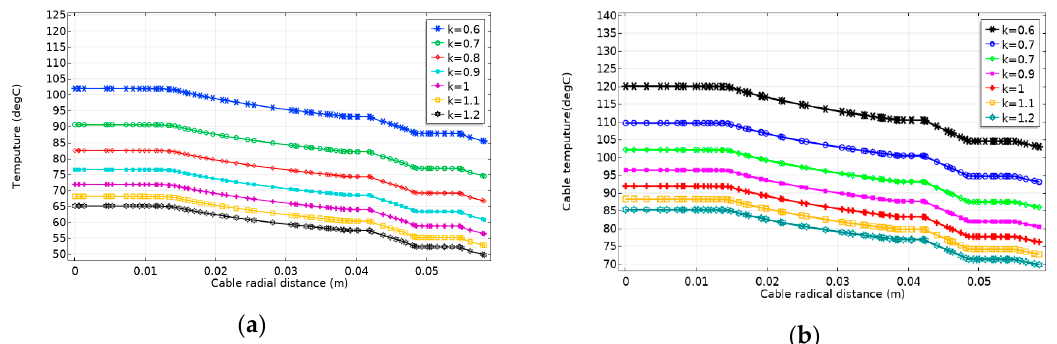
Figure 11. Changes in the radial temperature of the cable for two laying methods with different soil thermal conductivity. ( a ) Changes in the radial temperature of the cable for direct burial laying with different soil thermal conductivity. ( b ) Changes in the radial temperature of the cable for pipe laying with soil different thermal conductivity.